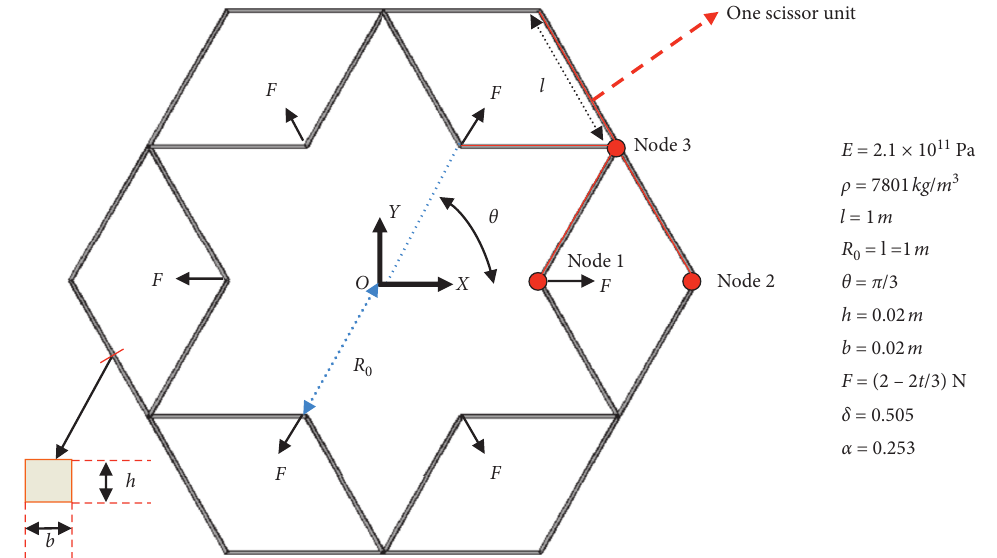
Figure 4: Initial mode shape of the ring array scissor-type deployable structure.